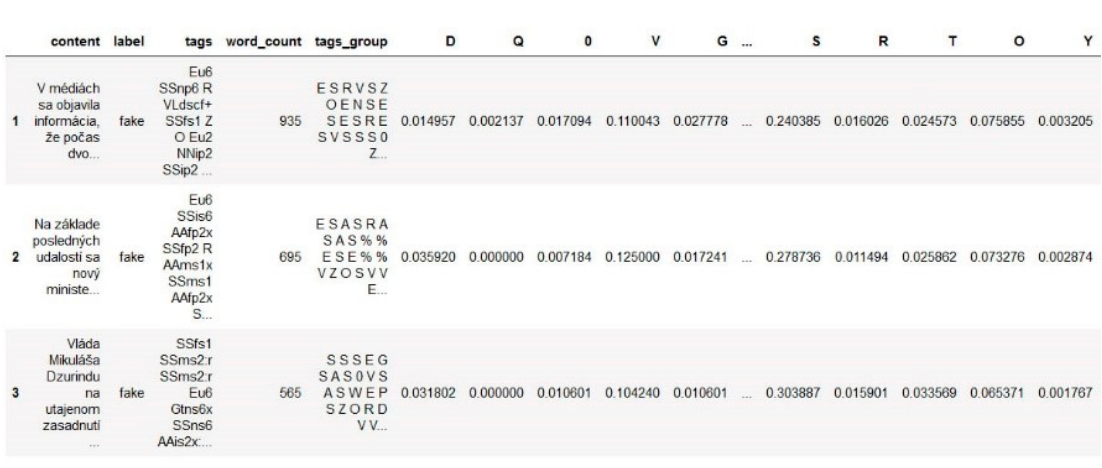
Figure 3. Preview of the dataset (Approach 1) created after identifying morphological tags and calculating the number of words in each article.